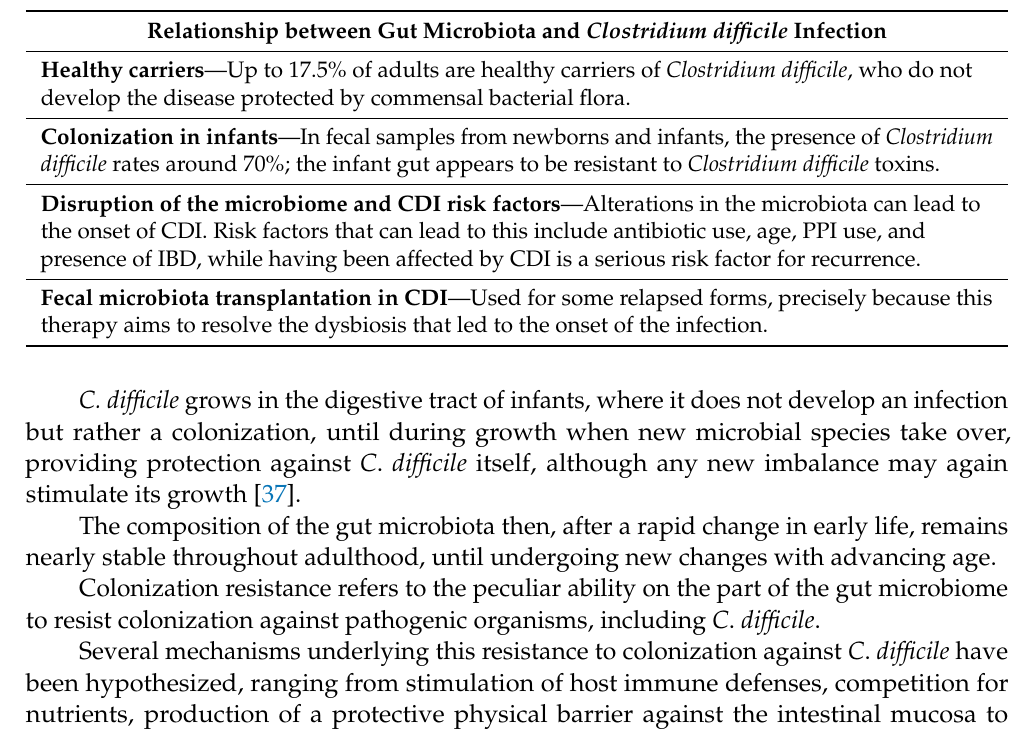
Table 3. Summary of some existing interactions between microbiome and the occurrence of Clostrid- ium difficile